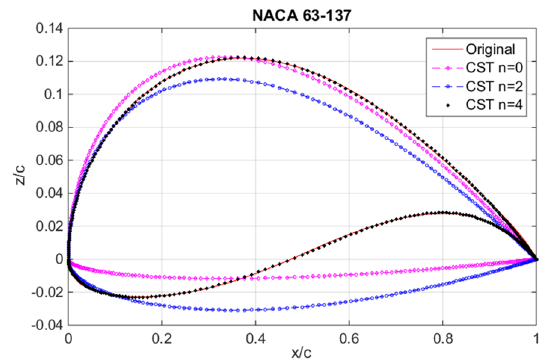
Figure 3. CST representation of NACA 63–137 airfoils.